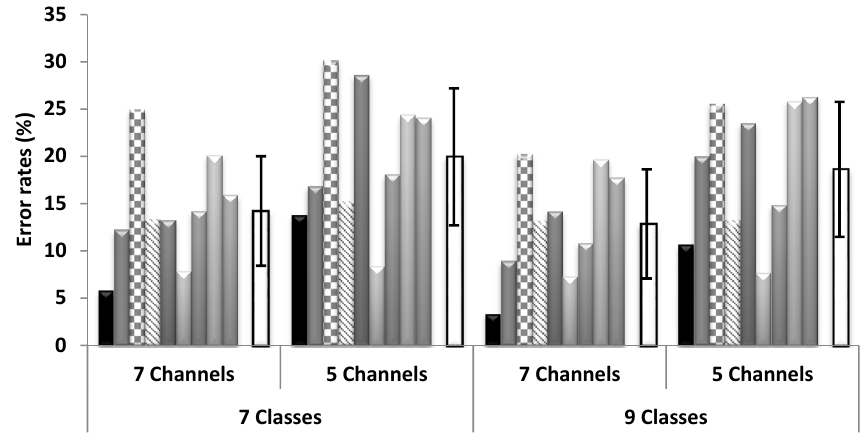
Figure 6. Error rates and the mean over 9 amputees for the proposed adaptive windowing framework and TD-PSD feature extraction (FE) method, with different movement/channel combinations for all nine amputees. SD is shown with error bars.